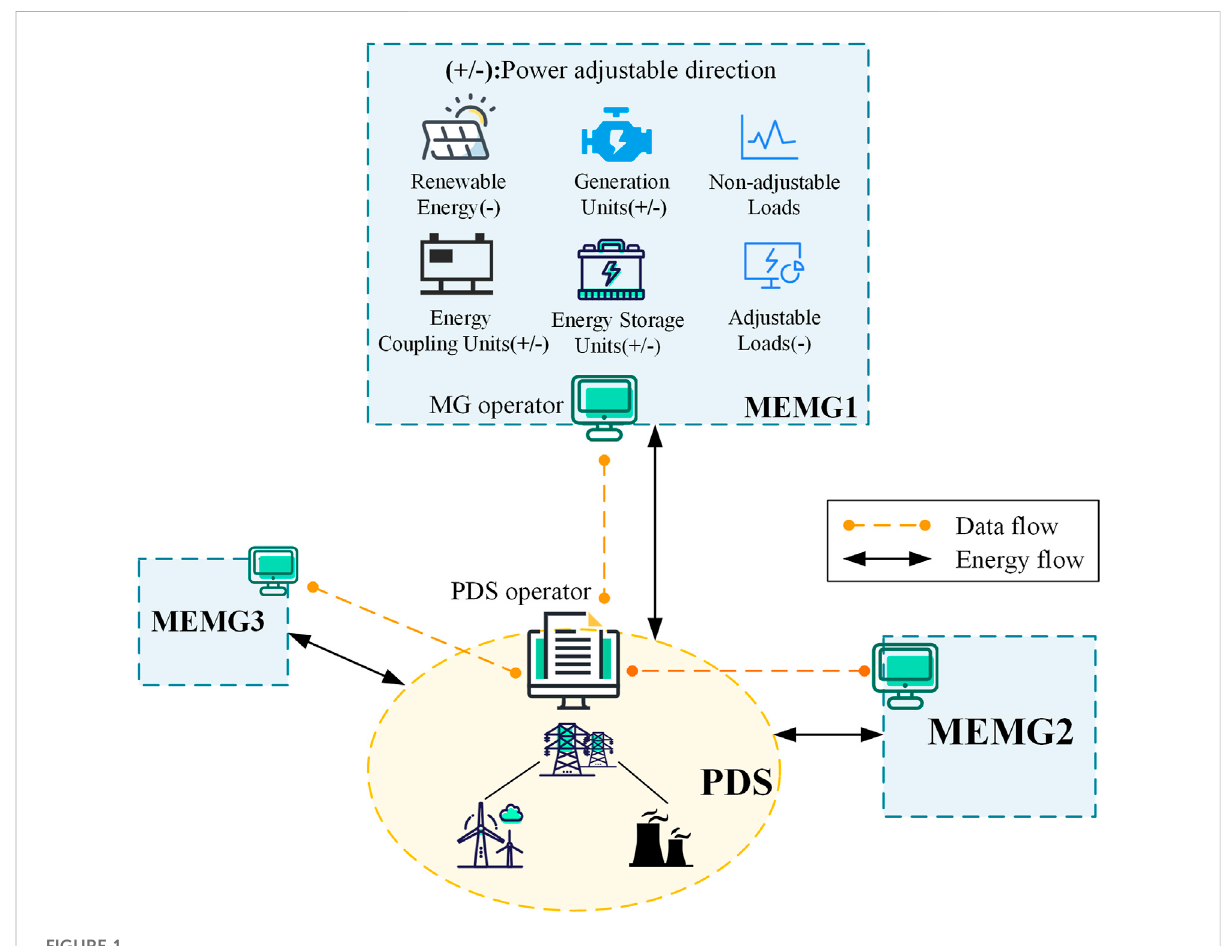
FIGURE 1 MG-PDS interactive